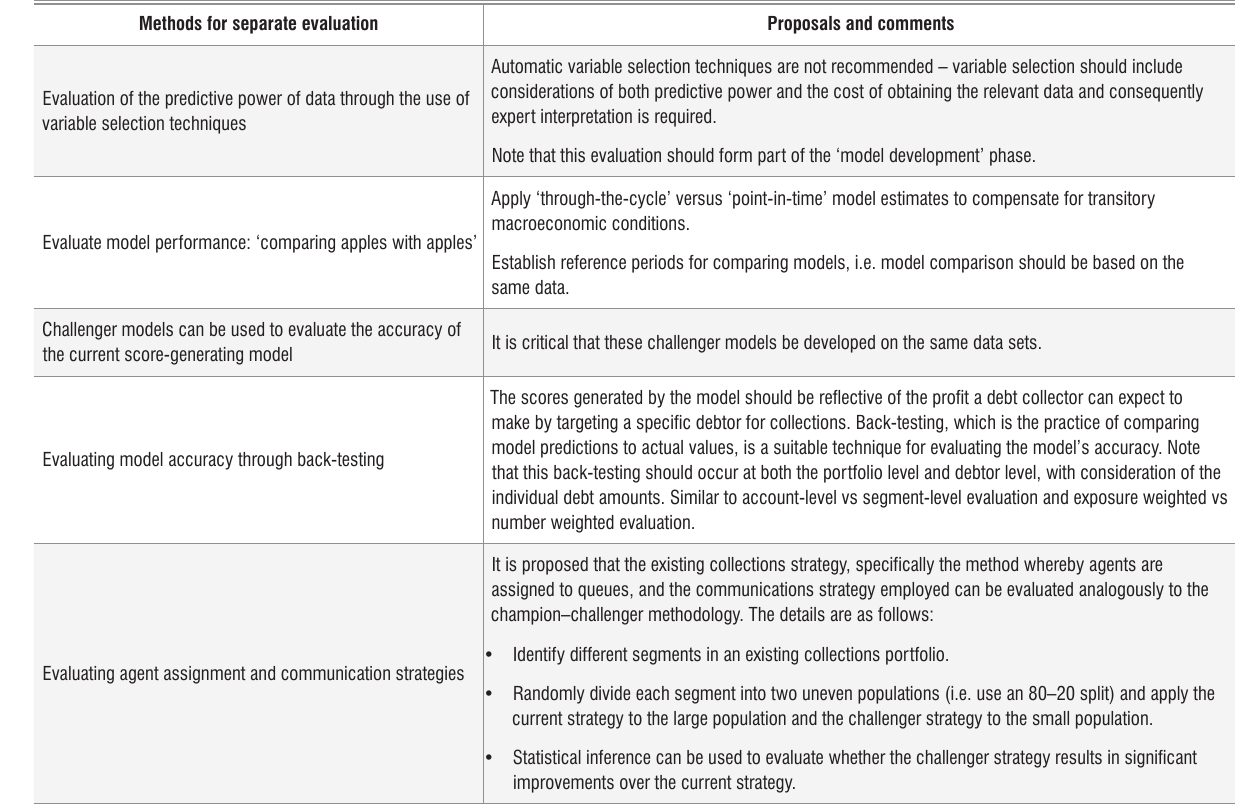
Table 6: Methods for separate evaluation Methods for separate evaluation Proposals and